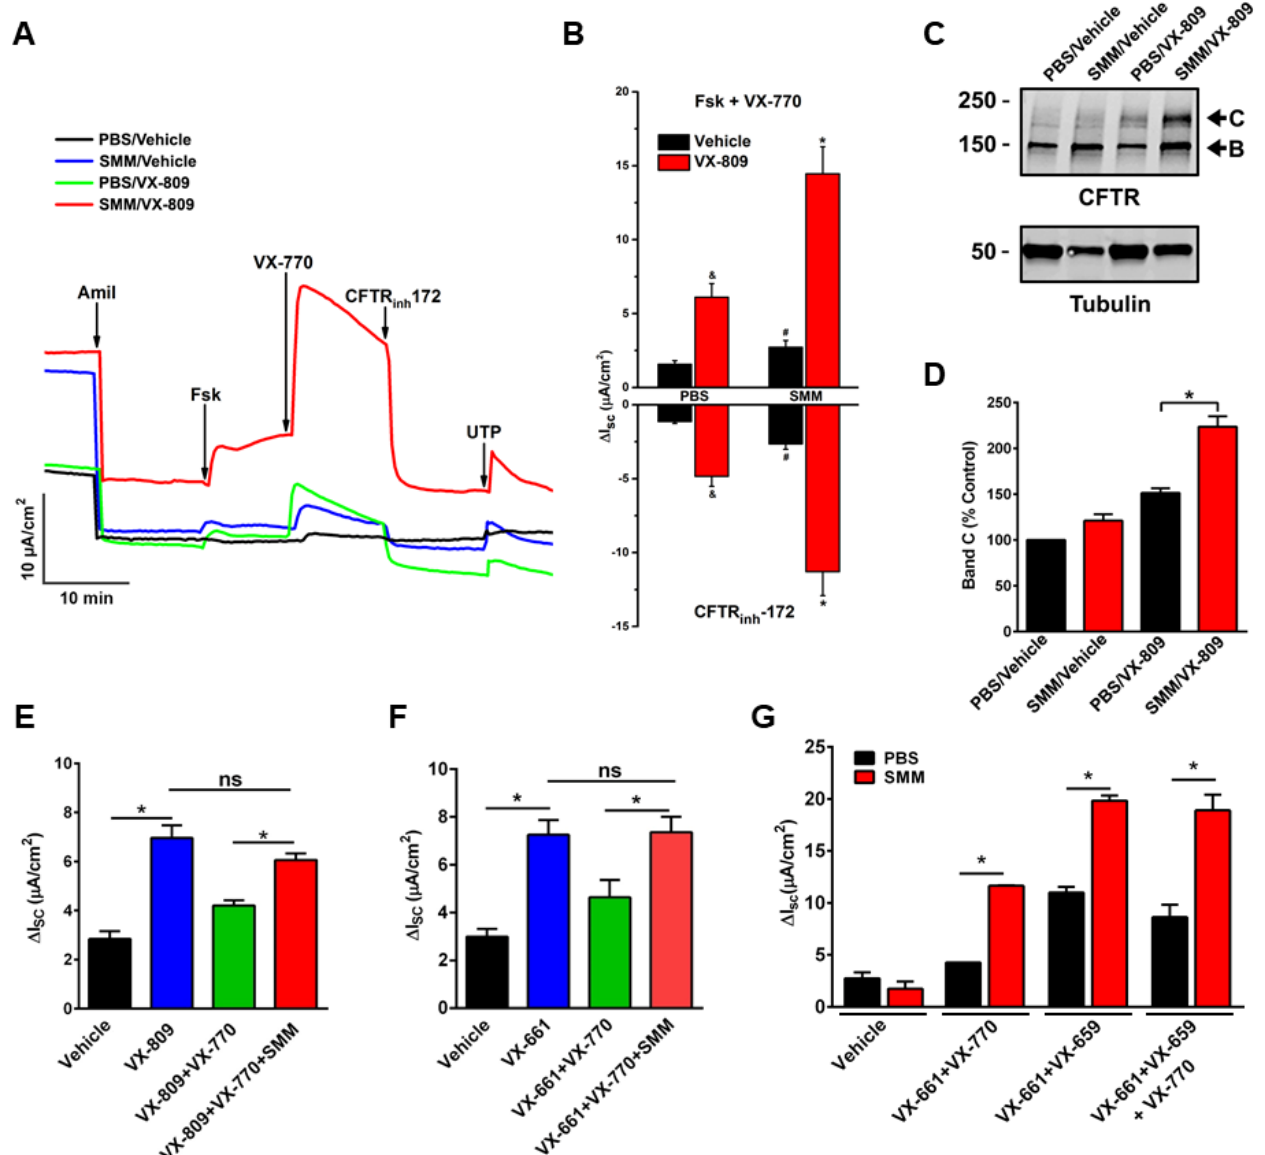
Figure 1. Exposure of CF HBE to SMM enhances F508del CFTR rescue. ( A – D ): CF HBE (F508del/F508del) cultures were exposed for 24 h to vehicle or 5 µ M VX-809 in combination with 30 µ L mucosal PBS or SMM. ( A ) Representative short-circuit currents (Isc, µ A/cm 2 ) recorded in Ussing chambers. ( B ) Quantification of F508del-mediated responses to forskolin (Fsk, 10 µ M) + VX-770 (1 µ M) and CFTRinh-172 (10 µ M). ( C ) Representative Western blot of immunoprecipitated CFTR and tubulin controls. ( D ) Quantification of band C as % values normalized from band C values from control (vehicle- and PBS-treated CF HBE). ( E ) SMM overcomes chronic VX-770 treatment (5 µ M, 48 h)-mediated abrogation of VX-809-promoted F508del CFTR rescue. ( F ) SMM overcomes chronic VX-770 treatment (5 µ M, 48 h)-mediated abrogation of VX-661-dependent F508del rescue. ( G ) SMM enhances triple combination-promoted F508del CFTR rescue. CFTR responses to acute forskolin + VX-770 from F508del/F508del HBE in Ussing chambers. HBE were treated with VX-659 (1 µ M), VX-661 (5 µ M), and VX-770 (5 µ M). All data are expressed as mean ± SEM. ( A – F ): n = 3–4 CF HBE donors, 3–4 cultures/donor. ( G ): 2 CF HBE donors, 5–6 cultures/donor. * p < 0.05. ( A – D ): Modified from Gentzsch et al., 2018 [58] (reproduced with permission of